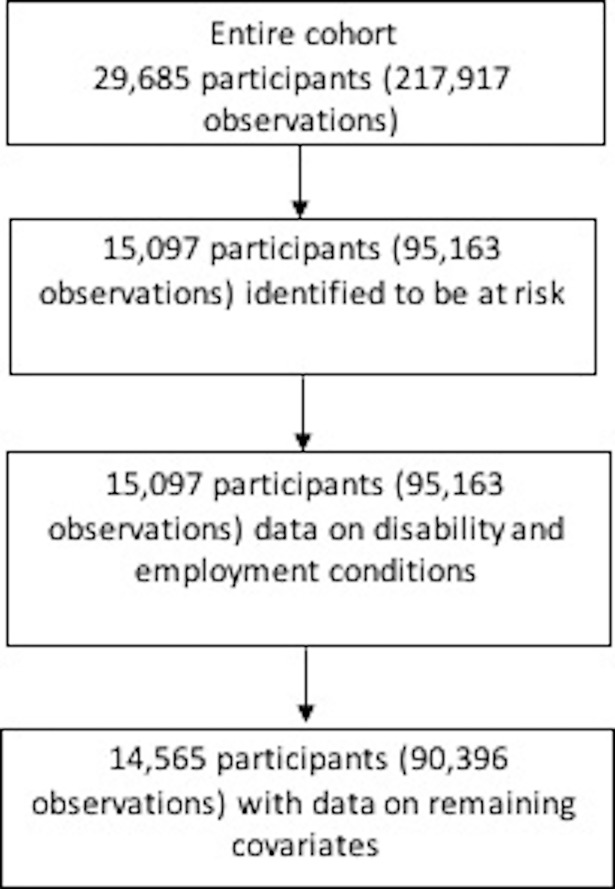
Sample selection.